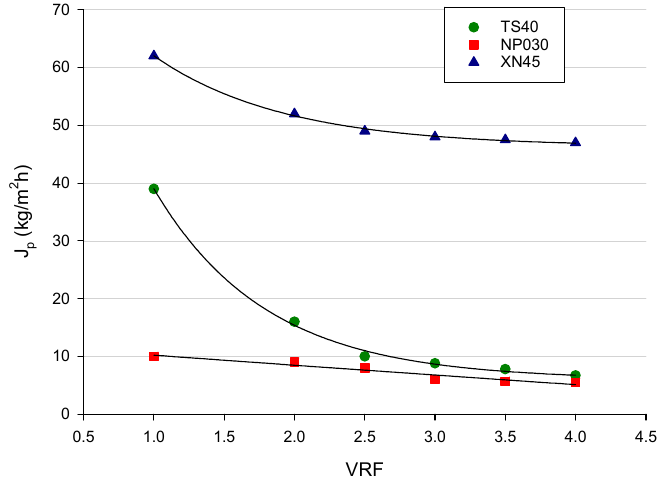
Figure 3. Nanofiltration in batch concentration mode of diafiltered apple juice with selected mem- branes. Permeate flux as a function of volume reduction factor (Operating conditions: TMP, 25 bar; Q f , 7 L/min; T, 25 ± 1 °C).